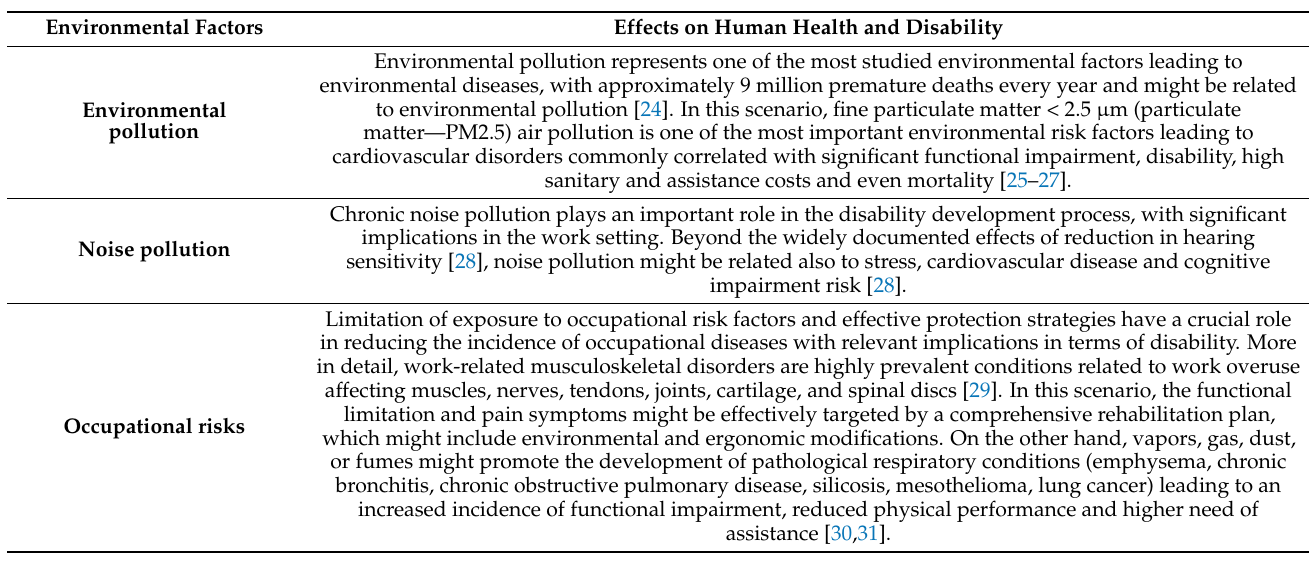
Table 2. The effects of environmental factors on risk of